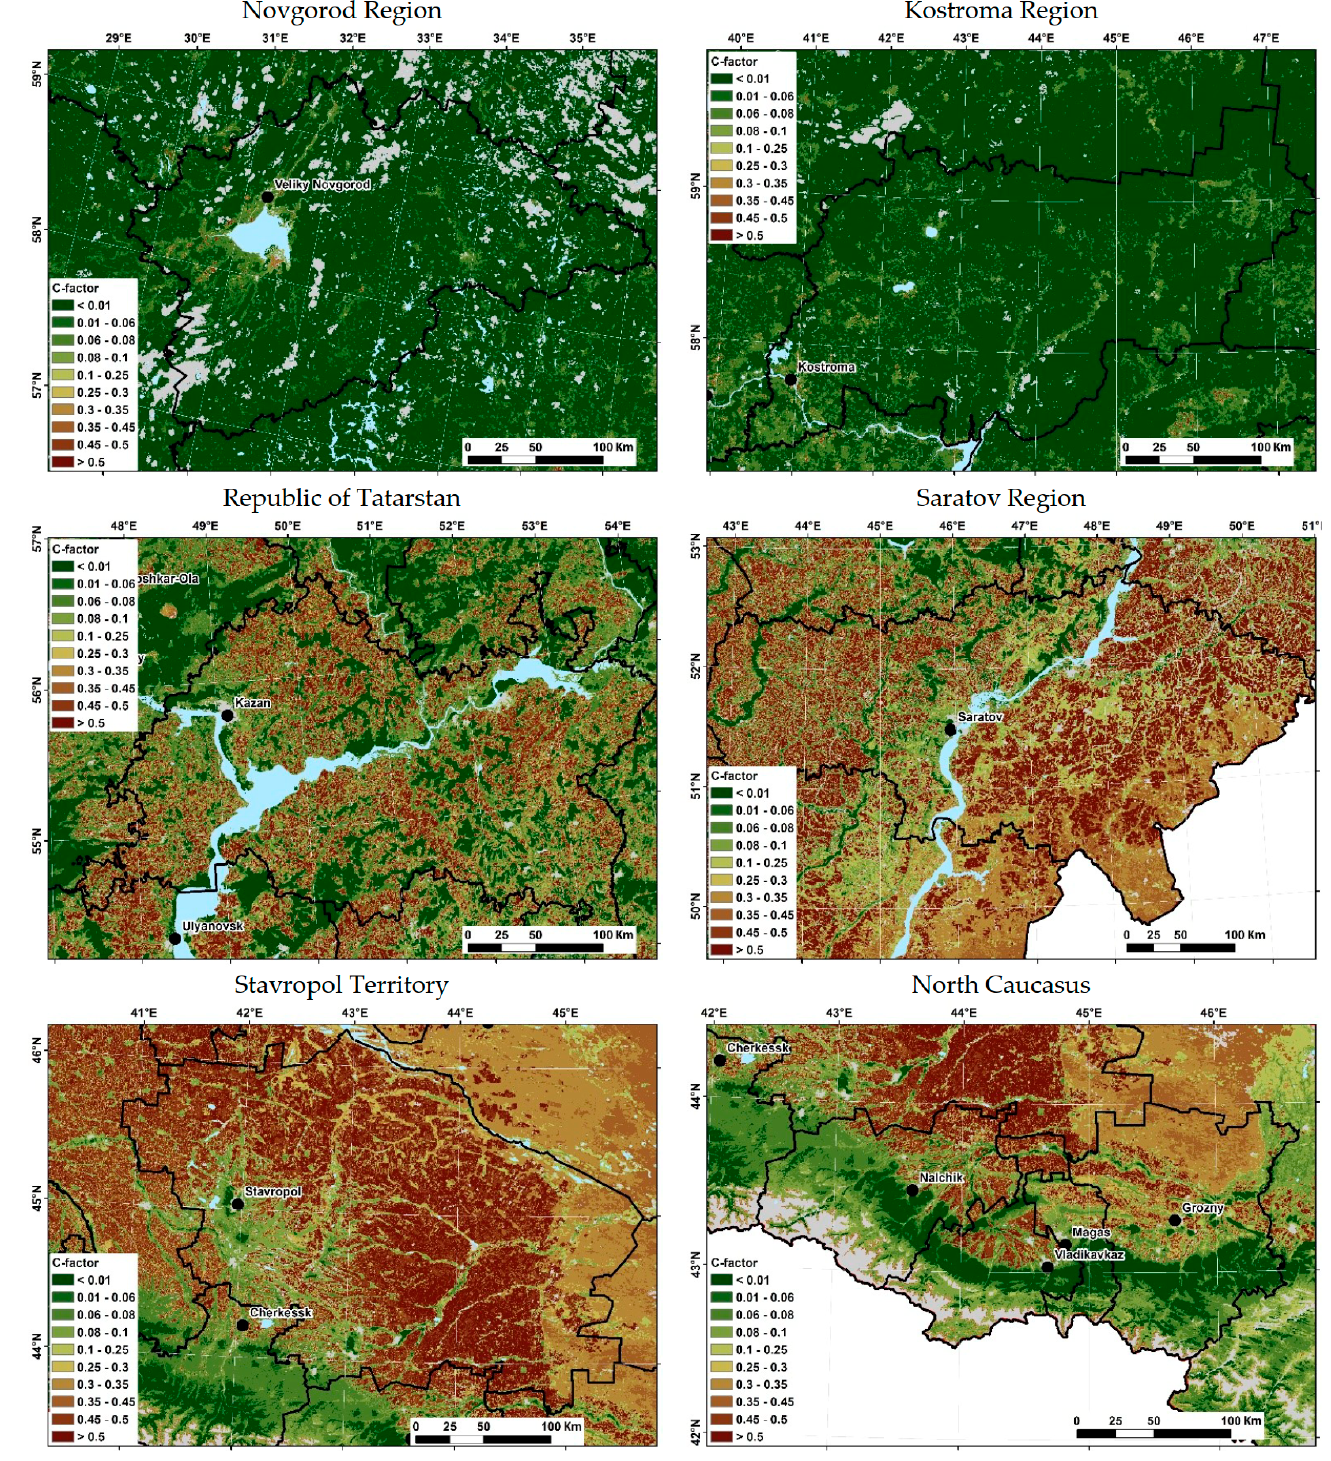
Figure 5. Spatial distribution of the C-factor (map fragments).